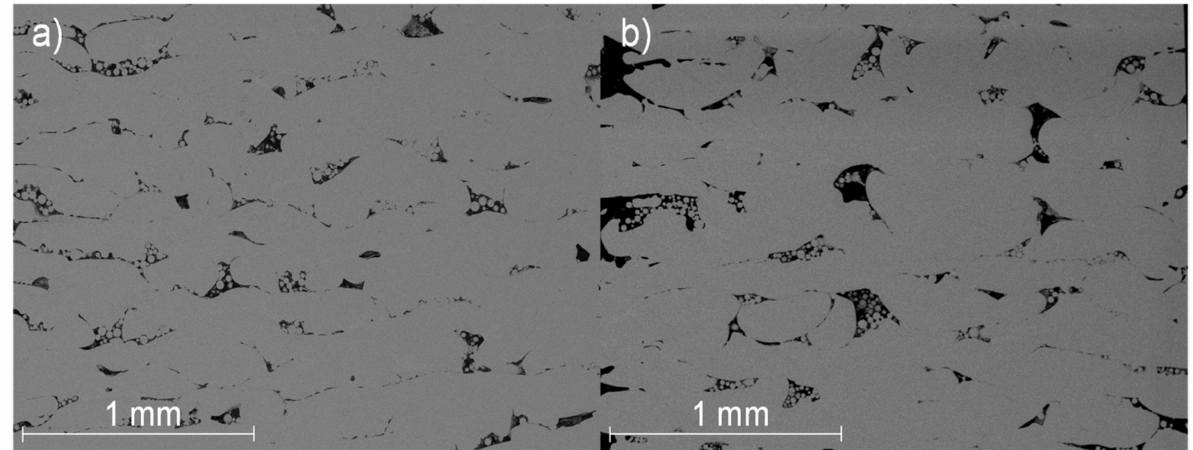
Figure 4. Optical images of the samples: ( a ) Ti-33 × 2; ( b ) Ti-50 × 2.